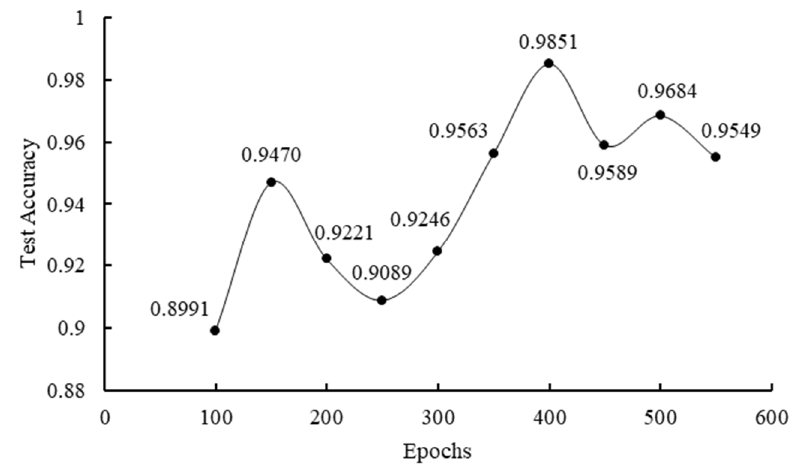
Figure 5. The relationship between test accuracy and epochs .